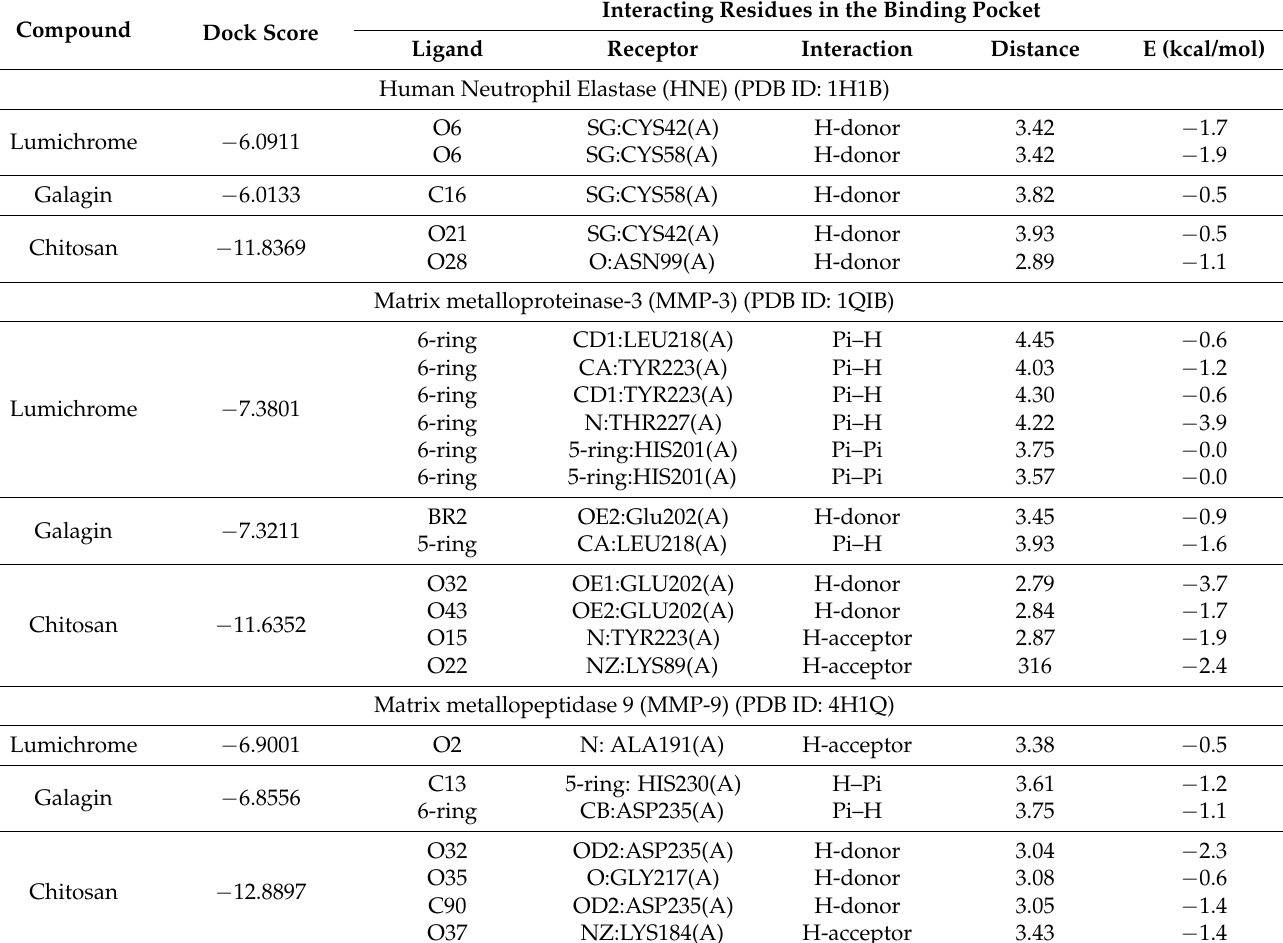
Table 6. Summary of binding interaction of the best hits with selected proteins from the database of 14